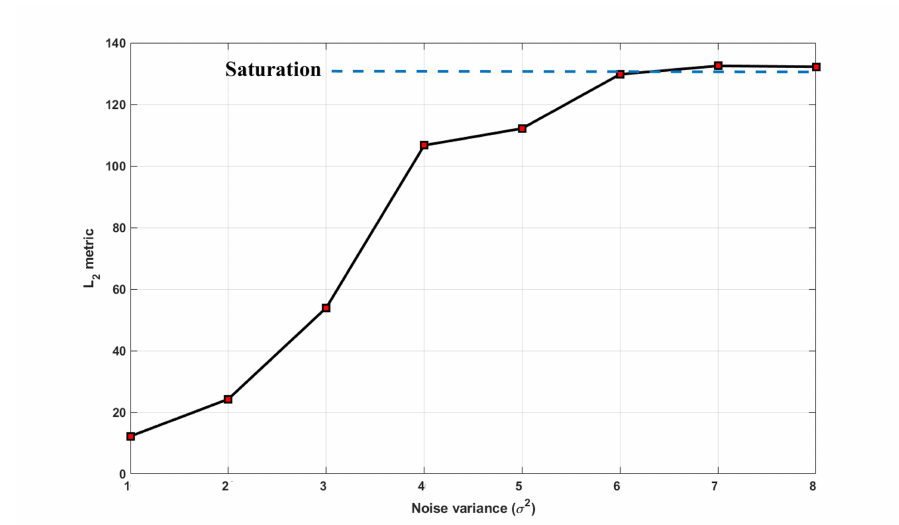
Figure 12. Uncertainty quantification of the LCP algorithm to noisy dataset D , measured via the metric in Definition 9, for spatial resolution ∆ x = ∆ y = 100